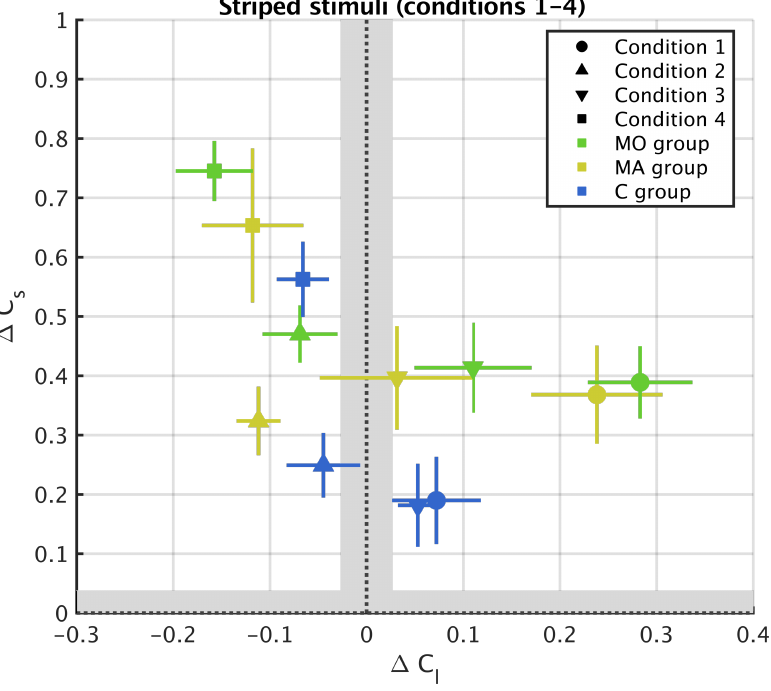
Figure 4. Experimental results for striped surround (Conditions 1–4 of Table 1) represented in the metric units (see Equation (1)). The term ∆ C l measures chromatic induction along the l axis of the MacLeod–Boynton colour space and ∆ C s measures chromatic induction along the s axis. The bigger | ∆ C | the stronger chromatic induction. Positive values of the metric ( ∆ C > 0) correspond to assimilation and negative values ( ∆ C < 0) to contrast. The grey region corresponds to one Just Noticeable Difference. The symbols and the bars respectively represent the mean and standard error of the mean in each group and for each